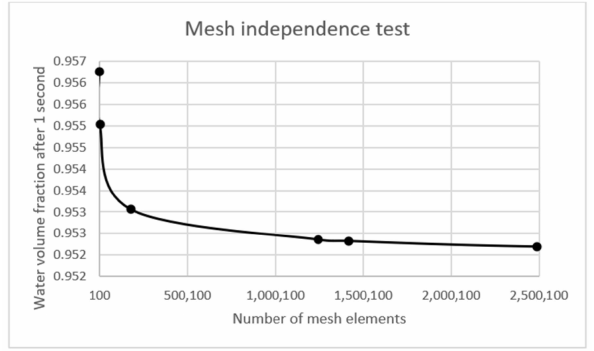
Figure 4. Mesh independence test results.